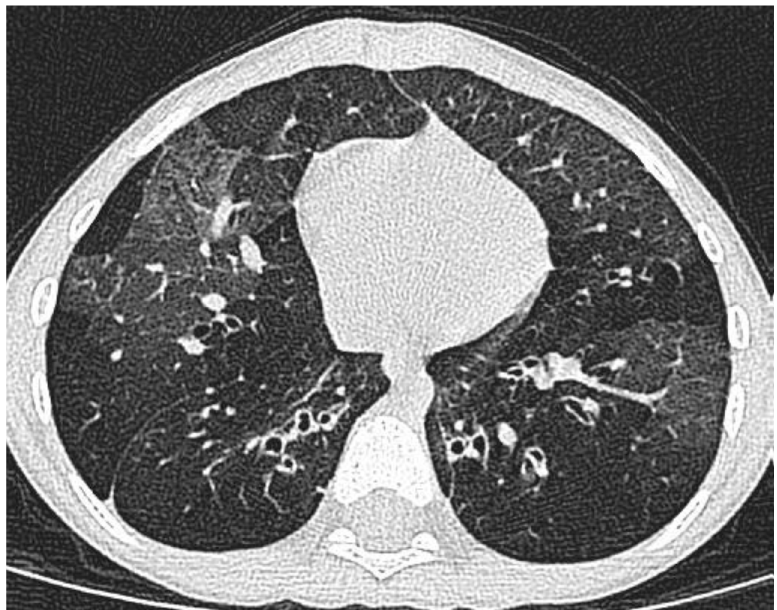
Figure 2. Not asthma at all. There is extensive large airway thickening and dilatation, with distal air trapping. This is bronchiectasis and obliterative bronchiolitis after a severe adenovirus infection. Table 2. Multidisciplinary assessment of severe, therapy-resistant asthma.